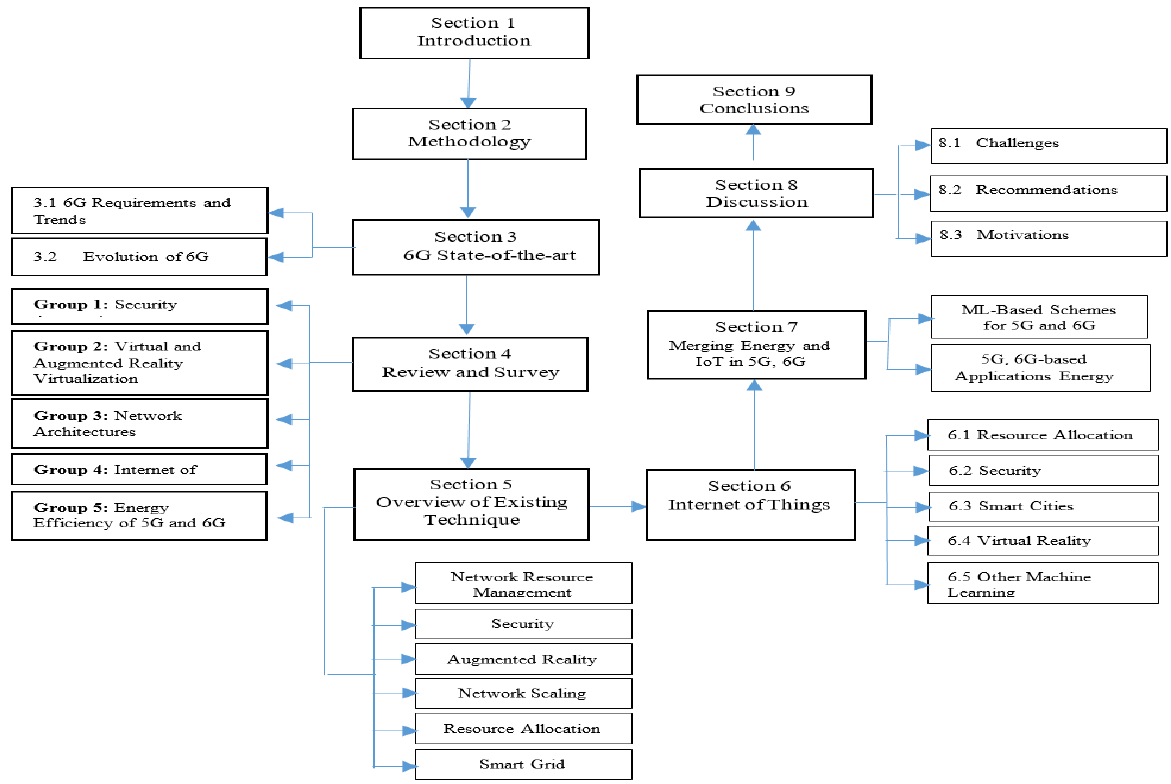
Figure 2. Diagramatic view of the organization of this survey